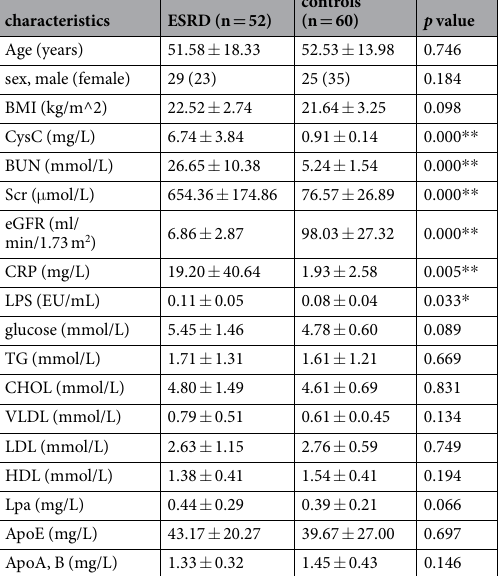
Table 1. Clinical parameters among ESRD patients and healthy controls. In this experiment, patients with diabetes and hyperlipidemia were excluded. Abbrevitions: CKD, Chronic kidney disease; BMI, body mass index; Scr, serum creatinine; CysC, Cystatin C; BUN, Blood Urea Nitrogen; eGFR, estimated glomerular filtration rate. CRP, C-reactive protein; LPS, Lipopolysaccharide; TG, Triglyceride; CHOL, Cholesterol; VLDL, very low-density lipoprotein; LDL, low-density lipoprotein; HDL, high density lipoprotein; Lpa, lipoproteins a; ApoE, apolipoprotein E; ApoA, B, apolipoprotein A, B * p < 0.05, ** p < 0.01. mean ±